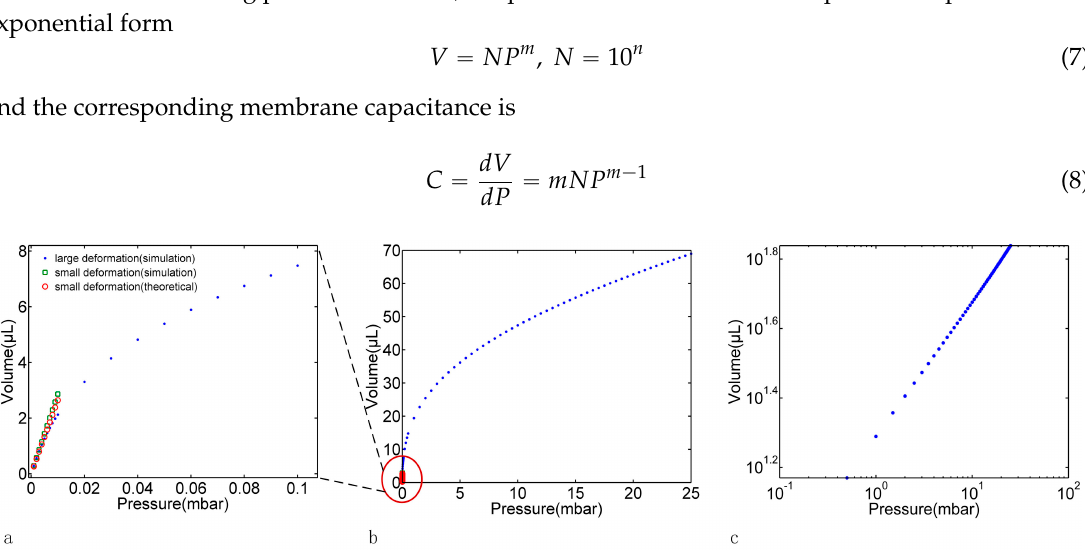
Figure 2. The pressure-volumes relationship of a deformed membrane based on the large deformation model and the small deformation model, ( a ) the magnifying view for the small deformation region; ( b ) the total view for the large deformation model; ( c ) the logarithmic view for the large deformation model. The uniform gas pressure was applied on the membrane, and the volume change was defined as the space wrapped by the outer boundary of the deformed membrane. The blue dot is the result of finite element simulation (FEM) based on the large deformation model, the green square is the result of FEM based on the small deformation model and the red circle is the result of small deformation based on the Equation (3).